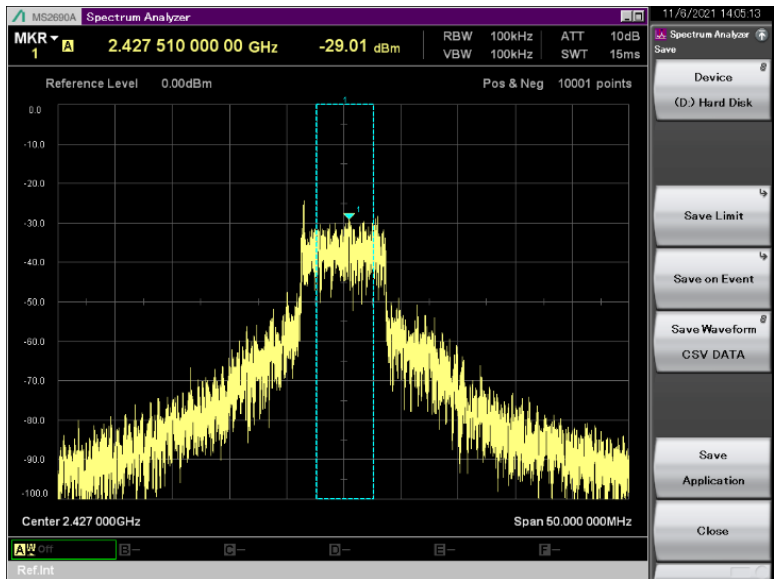
Figure 7. Jamming signal transmitted by the DronEnd ground system on channel 4 in the 2.4–2.5 GHz ISM band.